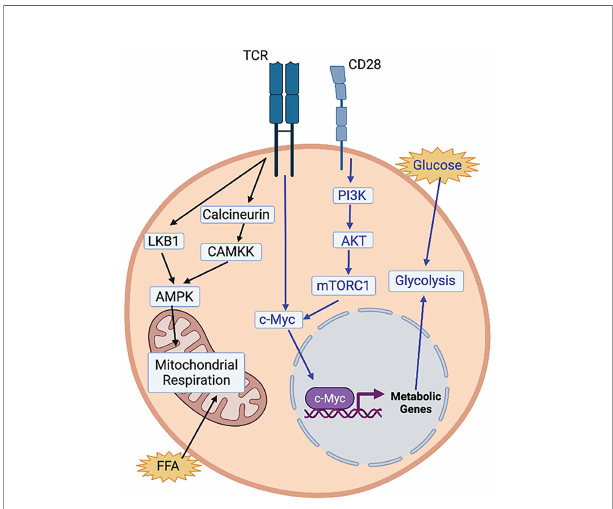
FIGURE 1 | Regulation of T cell activation by metabolic pathways. T cell receptor (TCR) activation activates AMPK via 2 pathways (black arrows). Via an LKB1-dependent pathway and via and LKB1-independent pathway, through calcineurin and CAMKK. Both AMPK and uptake of free fatty acids (FFA) activate mitochondrial respiration, which has been shown to be necessary for T cell activation. Activation of glycolysis is also essential for T cell activation (blue arrows). TCR activation activates c-Myc which turns on the expression of glycolytic metabolic genes. CD28 activation also activates c-Myc via the PI3K-AKT-mTORC1 pathway. Image created with